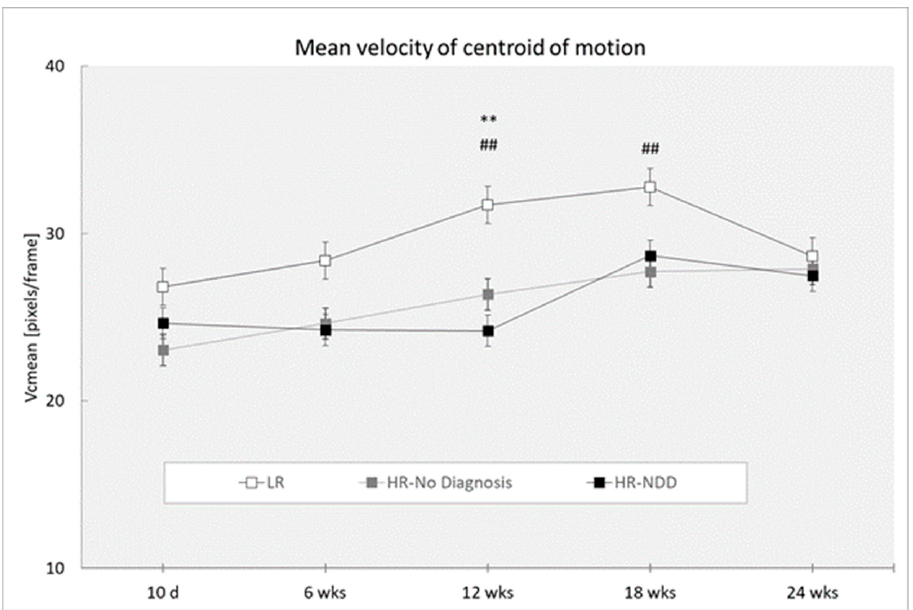
Figure 5. Mean velocity of centroid of motion in a 3-min session, measured at 10 days and 6, 12, 18, and 24 weeks in three groups of infants (LR, n = 53; HR-no diagnosis, n = 32; HR-NDD infants, n = 18). d = days; wks = weeks. Data are expressed as mean ± SEM. ** p < 0.01 between HR-NDD and LR infants; ## p < 0.01 between HR-no diagnosis and LR infants.